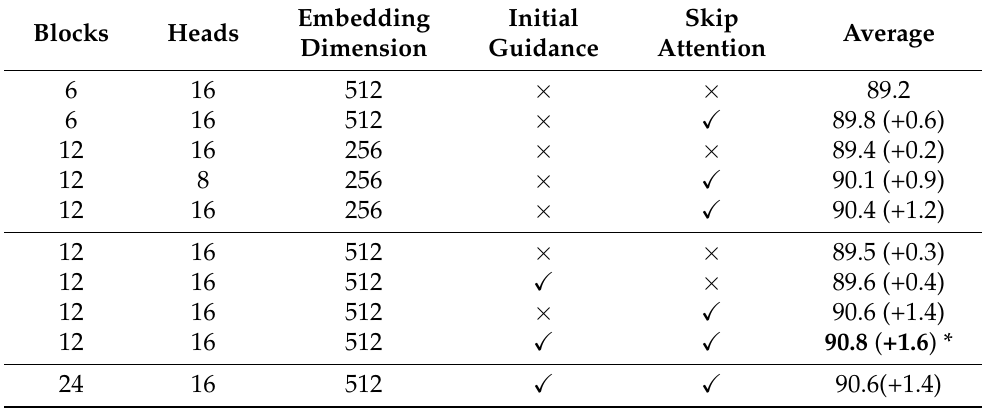
Table 5. Performance comparison with different settings. ’Initial guidance’ indicates the initial embedding guidance. ’Skip attention’ denotes the skip attention in the TFE. ’Average’ means the average accuracy of seven standard benchmarks. * denotes the setting of TRIG shown in Table 1. Embedding Initial Skip Blocks Heads